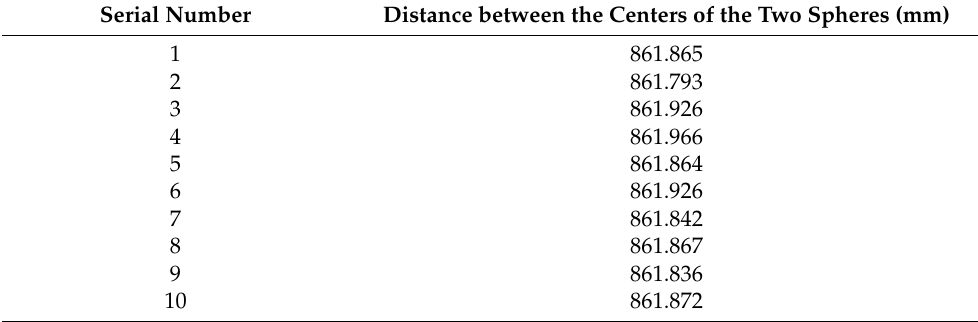
SAC algorithm, and the length of the sphere distance between the two ends of the stand- ard rod obtained by coordinate unification is 861.865 mm. The experiment was repeated ten times with the mobile robot, and the measured value of the joint contact arm was used as the real value of the sphere distance. The single measurement result was compared value, and the experimental results and data are shown in Table 8. with the real value, and the experimental results and data are shown in Table 8. Table 8. Data of ball center distance after coordinate Table 8. Data of ball center distance after coordinate unification.